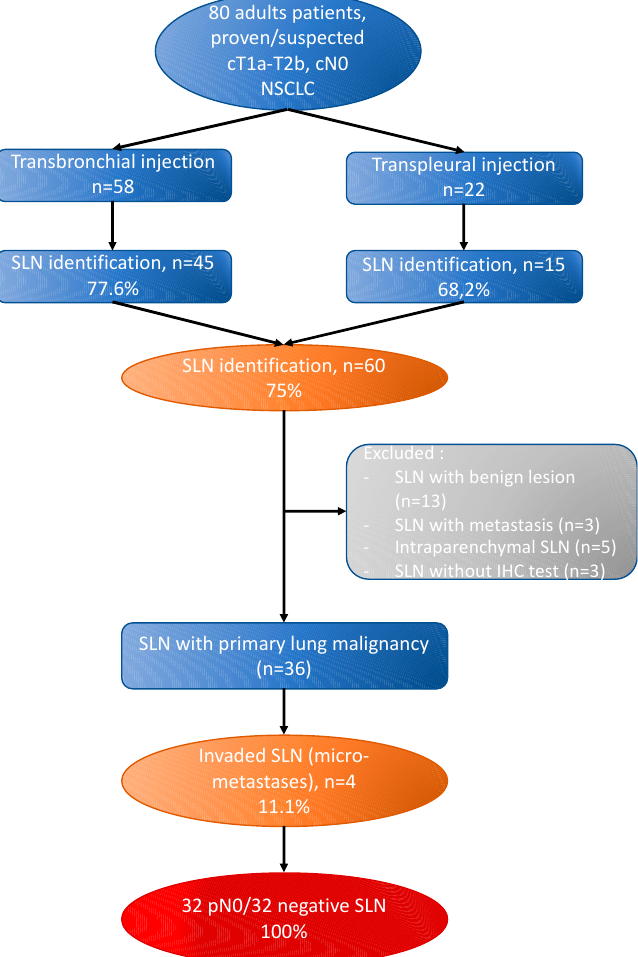
Figure 1. Flowchart of included patients. SLN, Sentinel Lymph Node; IHC, Immunohistochemical. In 56 of the 60 cases, the SLN was single (93.3%) and observed in two separated stations in four cases (6.7%). Among single SLNs, five were intraparenchymal (8.9%), 32 were located in N1 hilar and fissure stations (57.1%) and 19 were located in N2 mediastinal stations (33.9%). The exact locations of the SLN are detailed in Tables 3 and